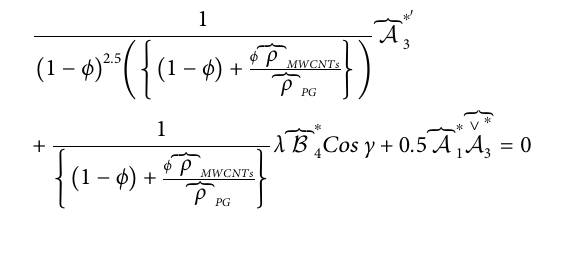
TABLE 4 | Summary of the dynamics of MWCNTs-PG against the pertinent fl ow parameters. Parameters